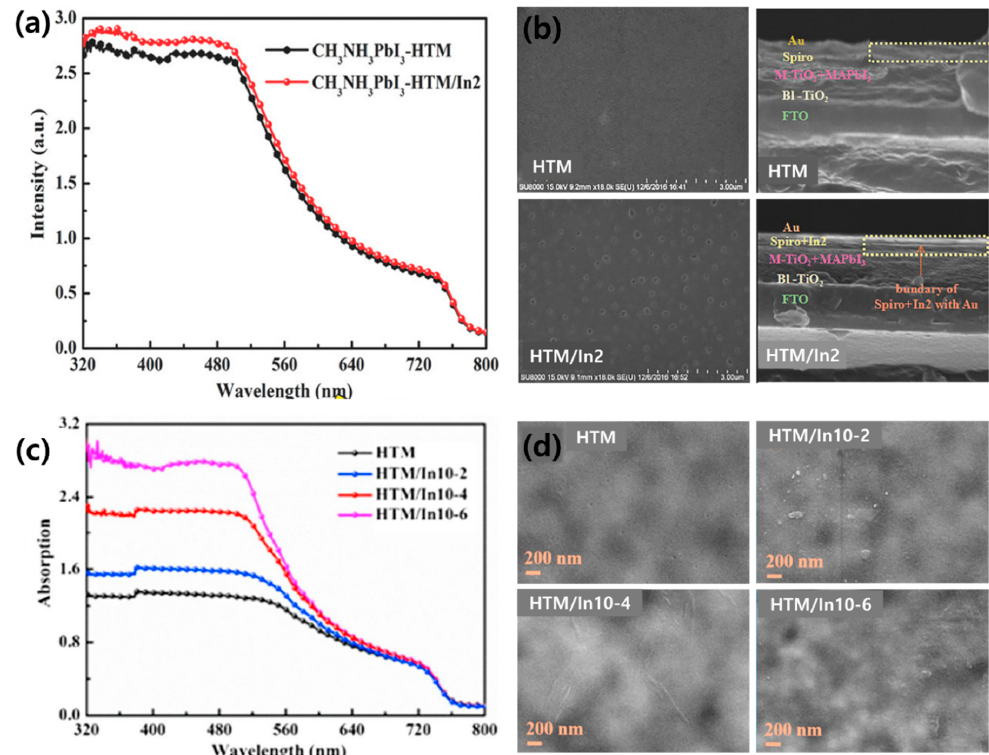
Figure 10. ( a ) UV-vis absorption spectra for the hole transport material (HTM) with and without In2 and ( b ) top view SEM images of films with and without In2. Reprinted from [149] with permission. Copyright© 2017, WILEY. ( c ) The UV-vis absorption spectra of the HTM with different amounts of In10 and ( d ) top view SEM images of HTM, HTM/In10-2, HTM/In10-4, and HTM/In10-6. Reprinted from [152] with permission. Copyright© 2019, Elsevier.